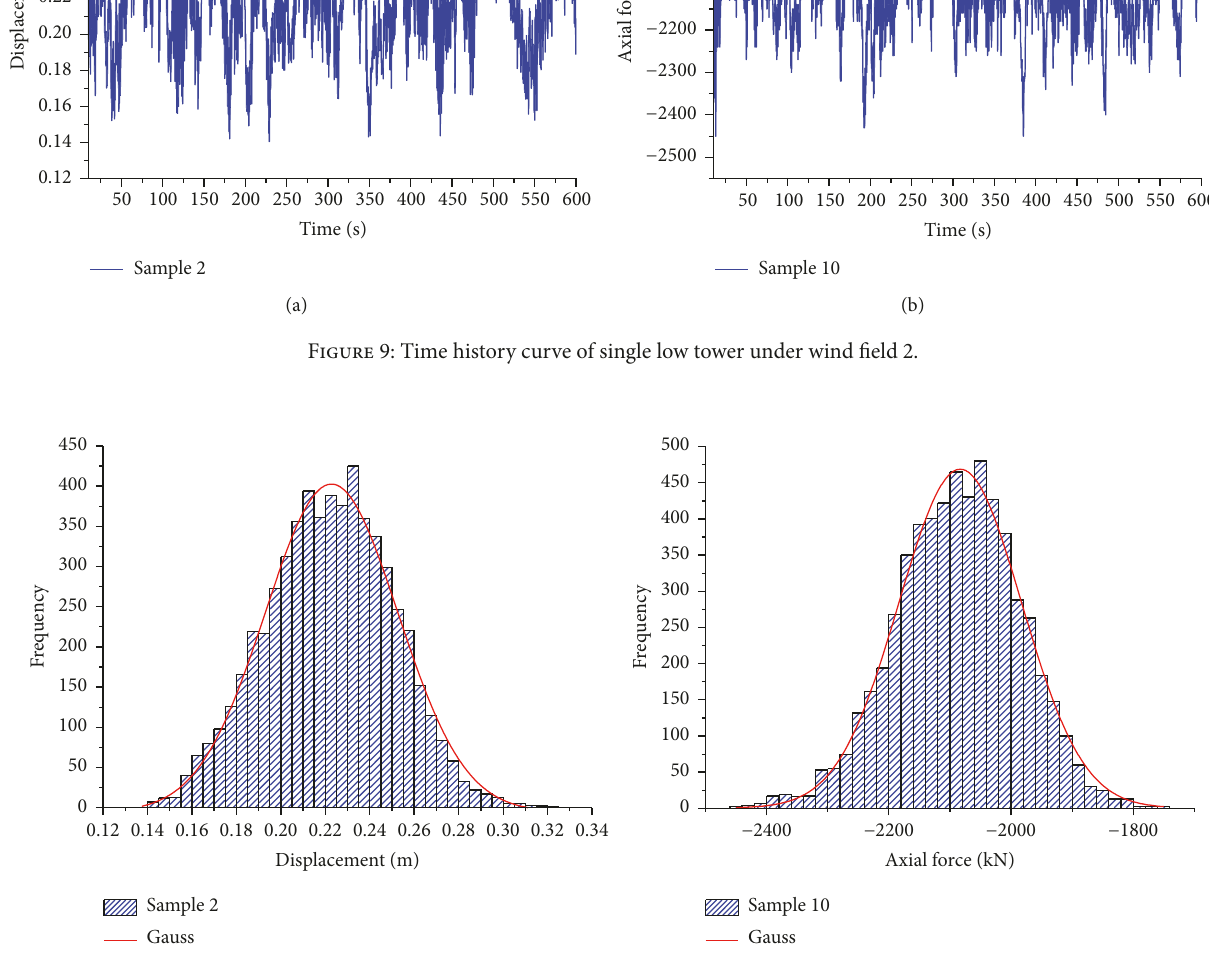
Figure 10: Frequency histogram of single low tower under wind field